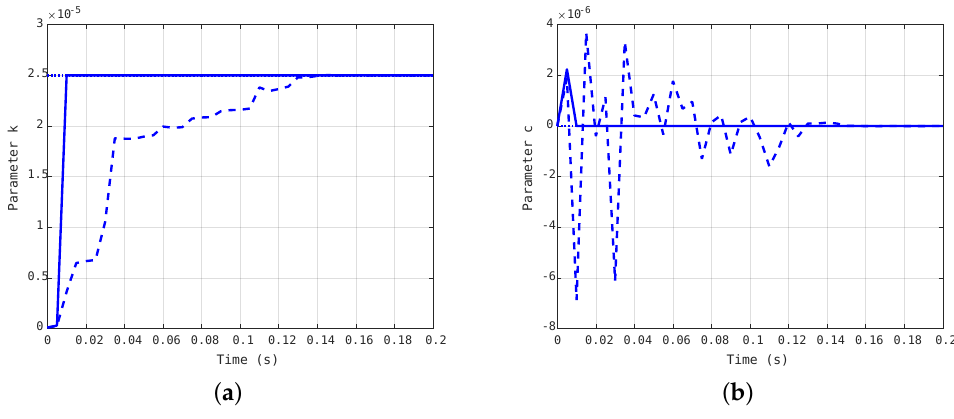
Figure 6. Time evolution of the estimated parameters k ( a ) and c ( b ) for the third case: c = 8.4 × 10 − 11 Nms/rad, k = 2.5 × 10 − 5